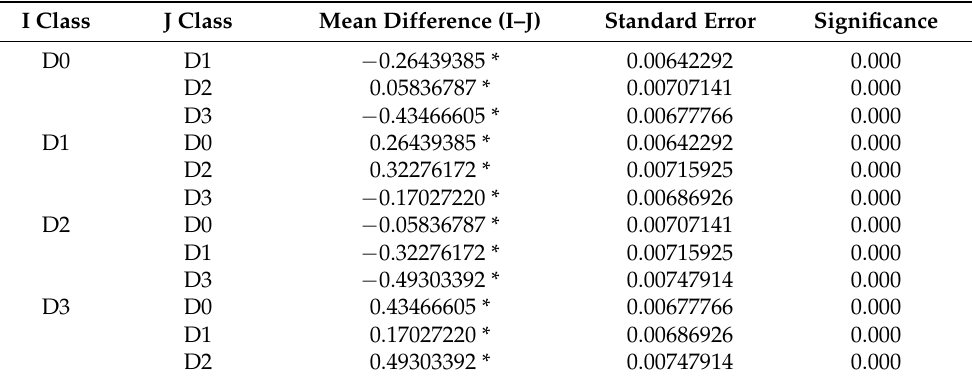
Table A2. Statistical Tukey’s honestly significant difference (HSD) test for the key wavelength of 715 nm for the four excess nitrogen treatments: D0, D1, D2 and D3.